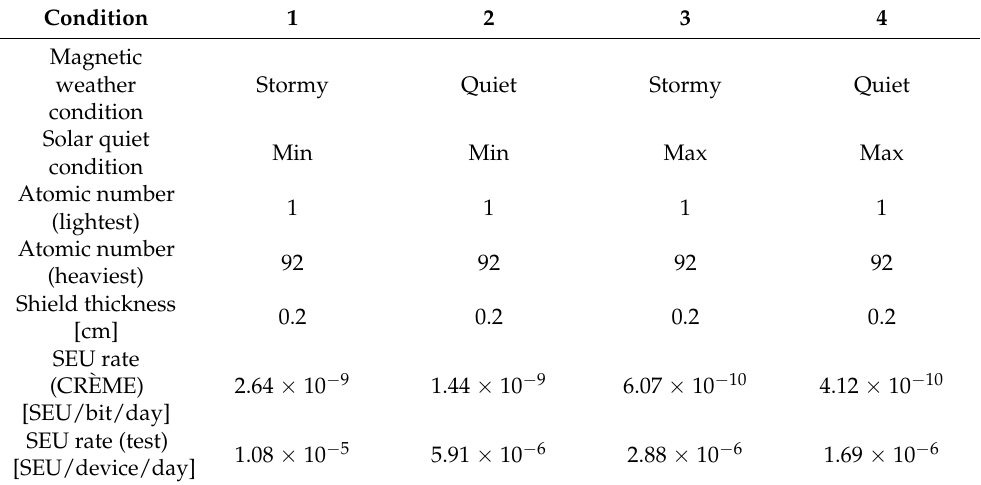
Table 8. CR È ME [23] analysis conditions and results.